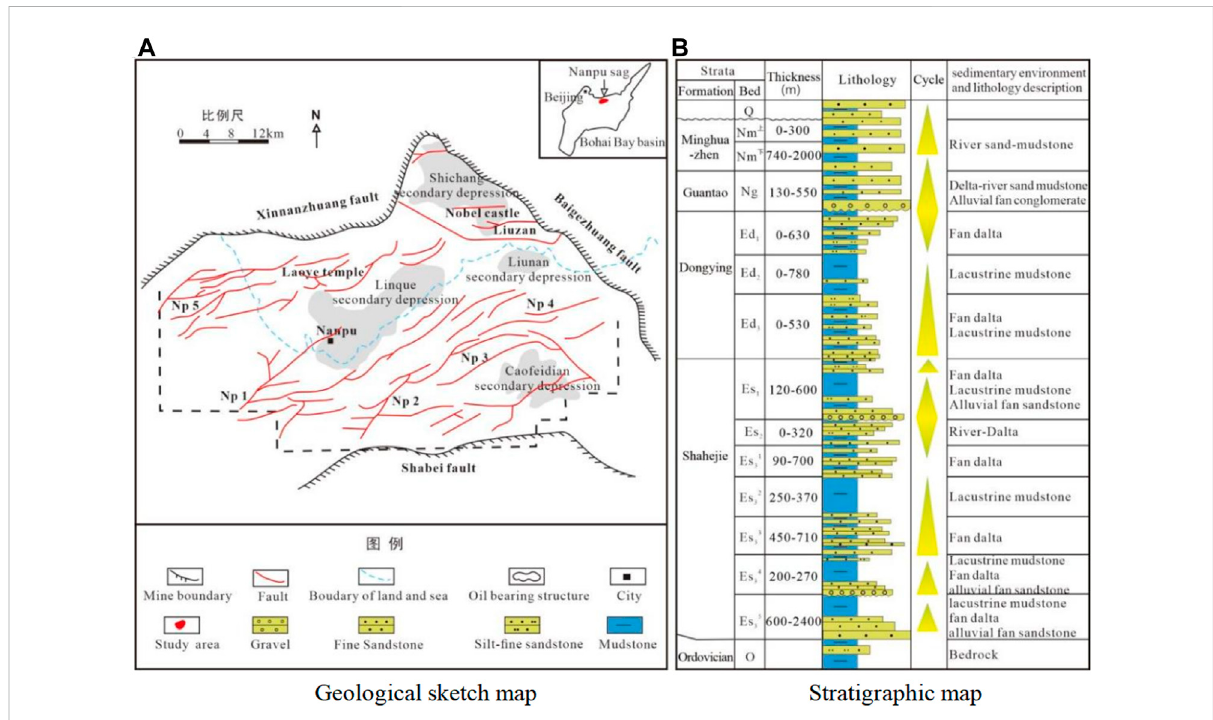
FIGURE 1 Structural and comprehensive geological histogram of the study area. (A) Geological sketch map (B) Stratigraphic